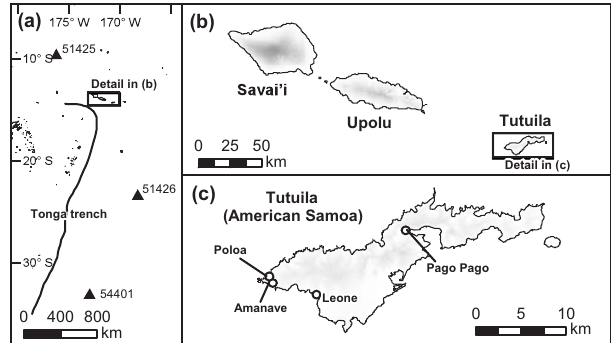
Figure 1. Study area (Pago Pago, Leone, Poloa and Amanave, American